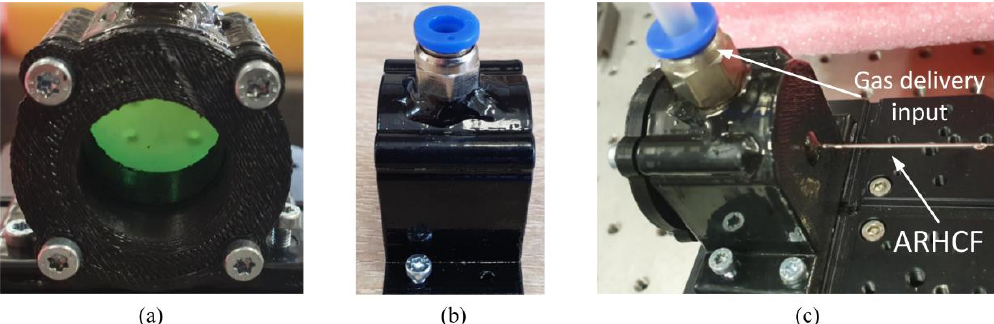
Figure 4. Photographs of a 3D-printed airtight housing used for filling the ARHCF core with the